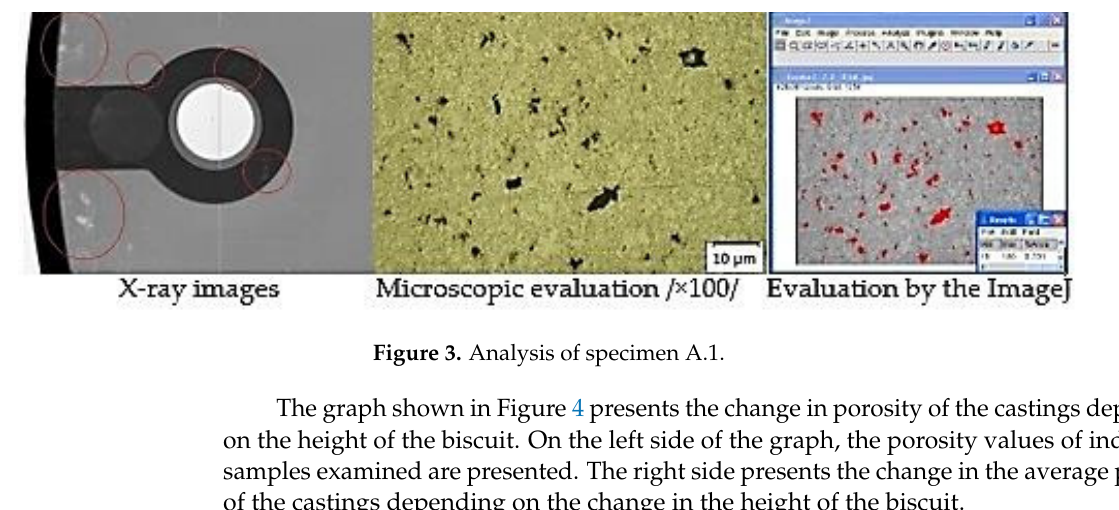
Figure 2. Analysis of specimen C.1.